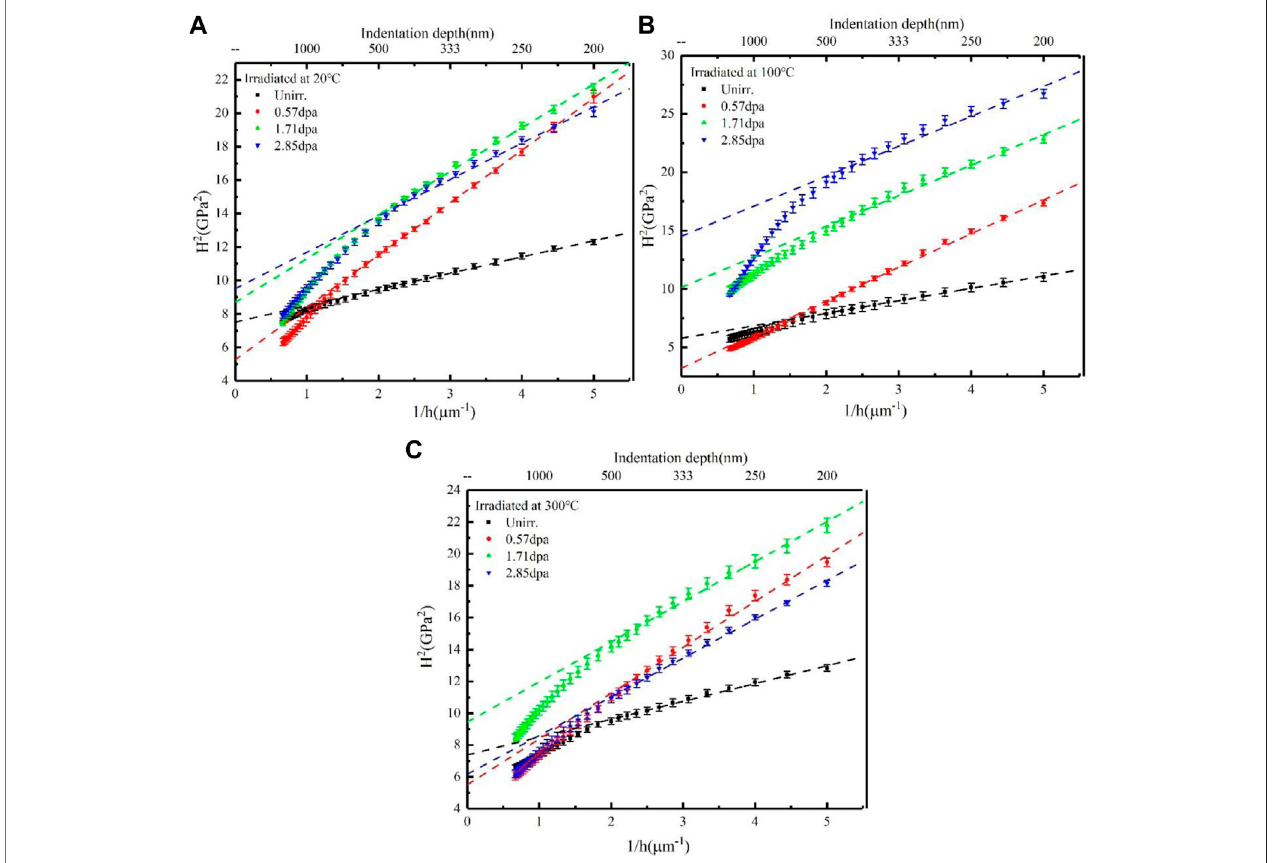
FIGURE 5 | H 2 − 1/ h curves of F321 stainless-steel irradiated at (A) 20 ° C, (B) 100 ° C, and (C) 300 ° C.